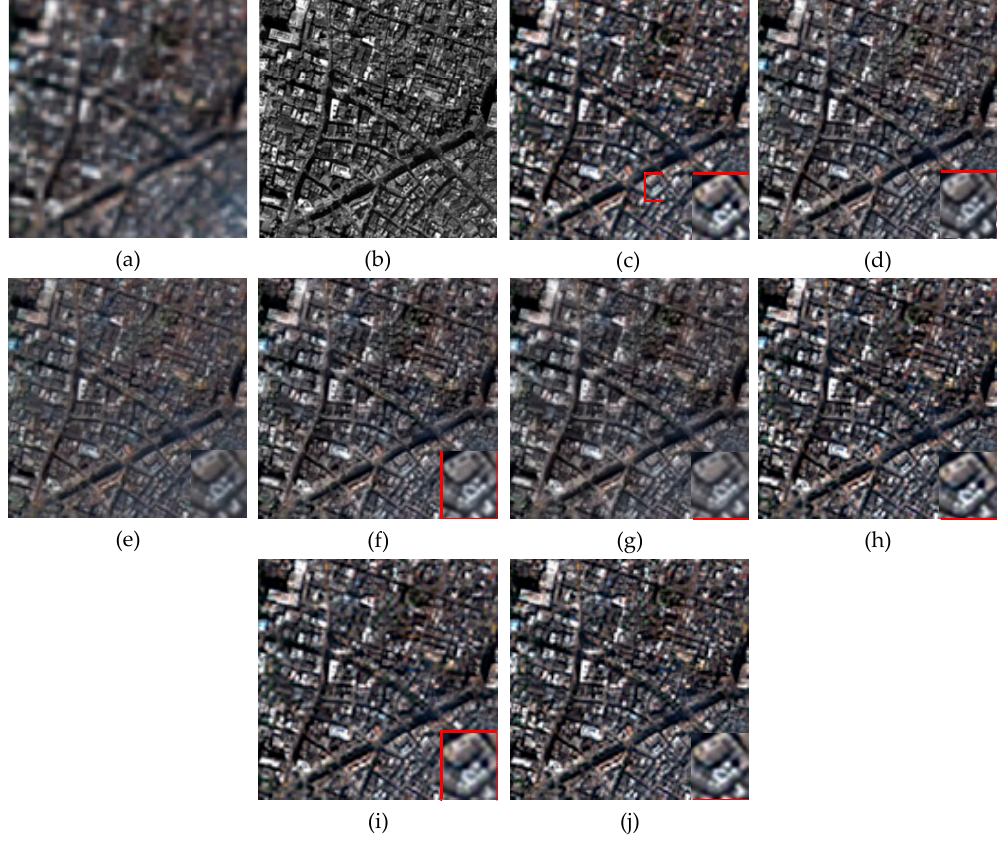
Figure 9. Fusion results of reduced-scale QuickBird images. ( a ) LR MS image, ( b ) PAN image, ( c ) reference image, ( d ) GIHS [49], ( e ) principal component analysis (PCA) [6], ( f ) AWLP [50], ( g ) support value transform (SVT) [12], ( h ) SparseFI [32], ( i ) NE, ( j ) SWNE. Table 1. Numerical results of each fused image shown in Figure 9.